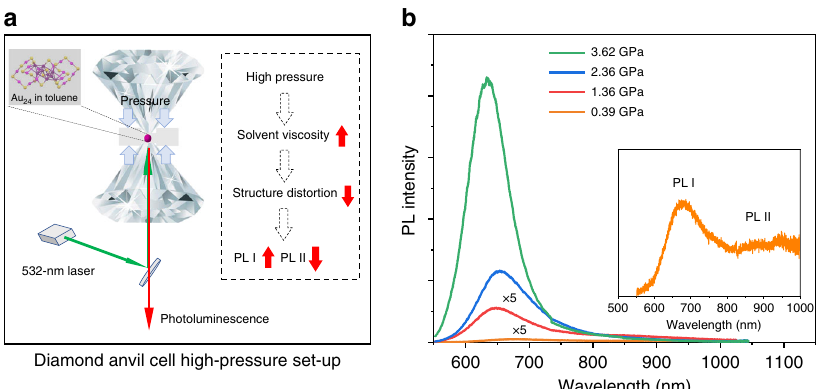
Fig. 4 Pressure-dependent PL study of Au 24 . a The diamond anvil cell high-pressure set-up. Au 24 in toluene is loaded inside the diamond anvil cell and compressed between the diamond anvils. Inset: mechanism of the pressure-induced change of the dual emission. b The pressure-dependent PL spectra of Au 24 . Inset: enlarged PL spectrum of Au24 at 0.39 GPa. PL photoluminescence.